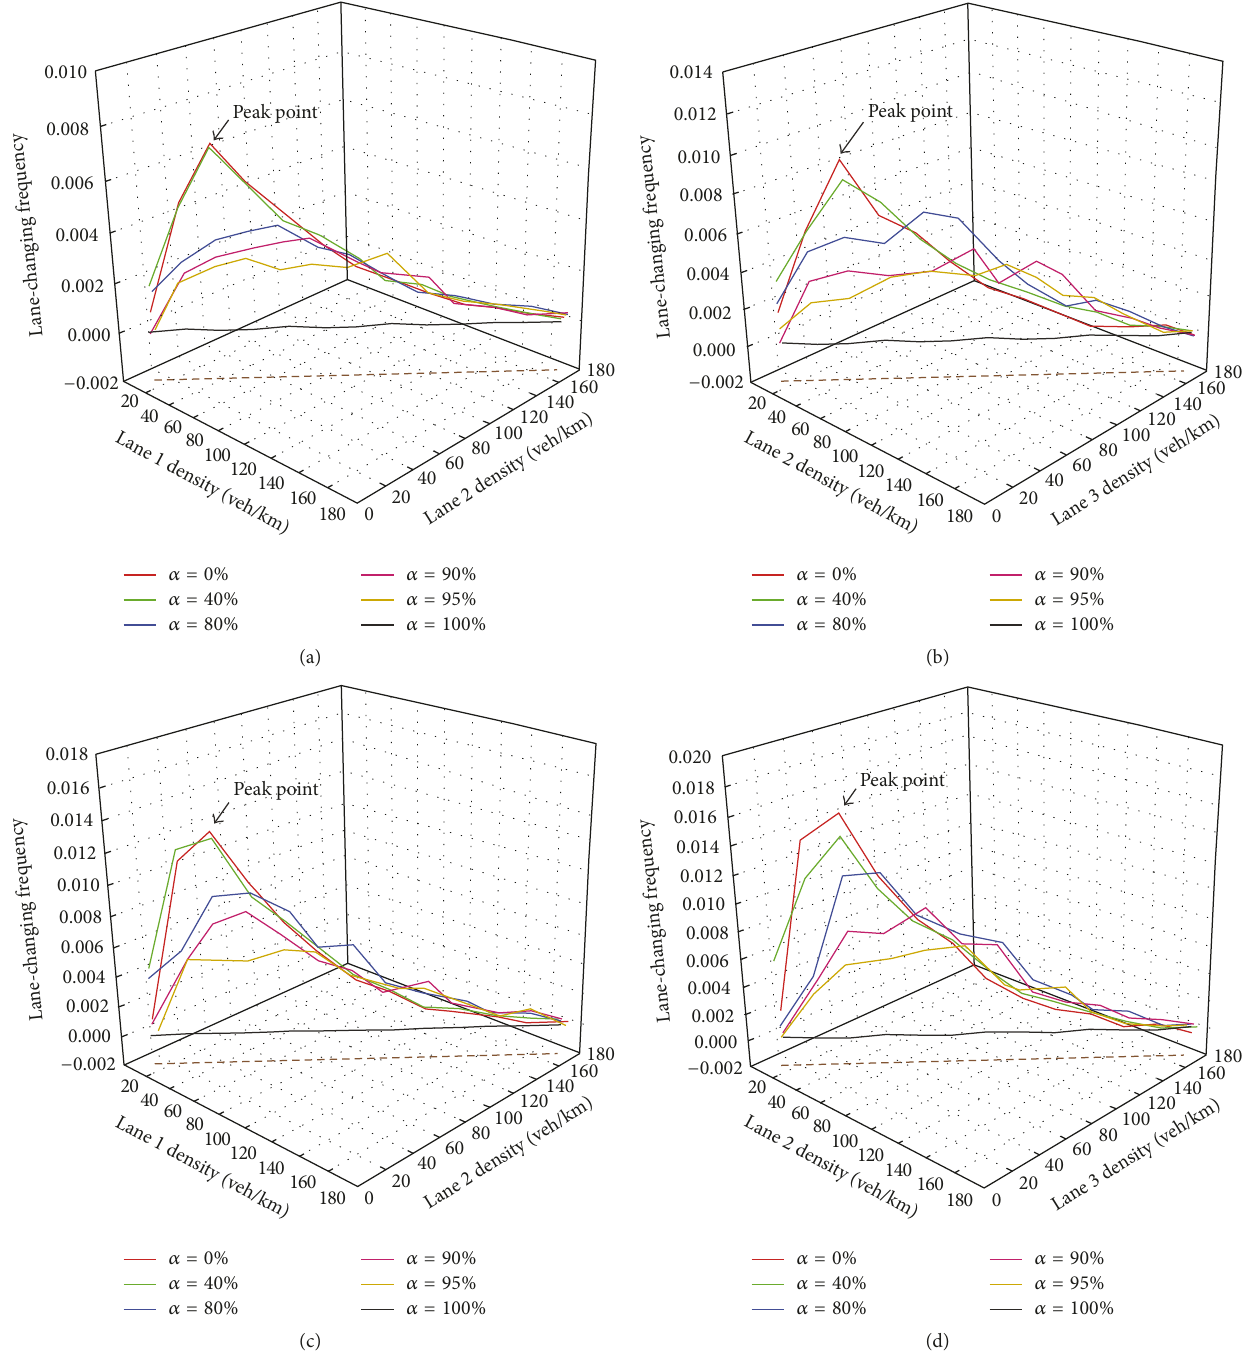
Figure 5: Lane-changing frequency of mixed traffic flow: (a, c) 𝑖 = 1 and 𝑗 = 2 ; (b, d) 𝑖 = 2 and 𝑗 = 3 ; (a, b) PLC; (c, d) ALC.